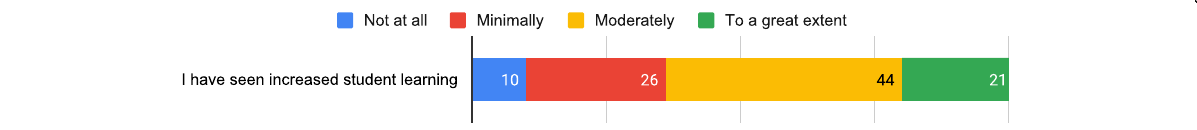
Fig. 7 Student impact. Percentage of respondents reporting benefits to participating in the FOLC in spring 2019 (end of year 2 of the FOLC). Participants rated the extent to which each benefit had occurred as a result of their participation in the FOLC. Items were not presented to participants in this order or identified with the category student impact . ( N =